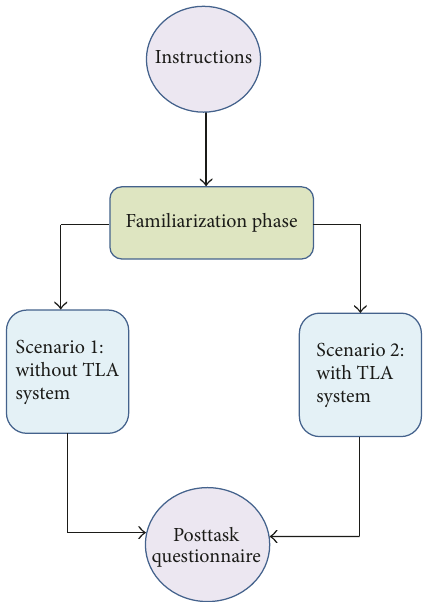
Figure 3: Flow chart of the experimental procedure.